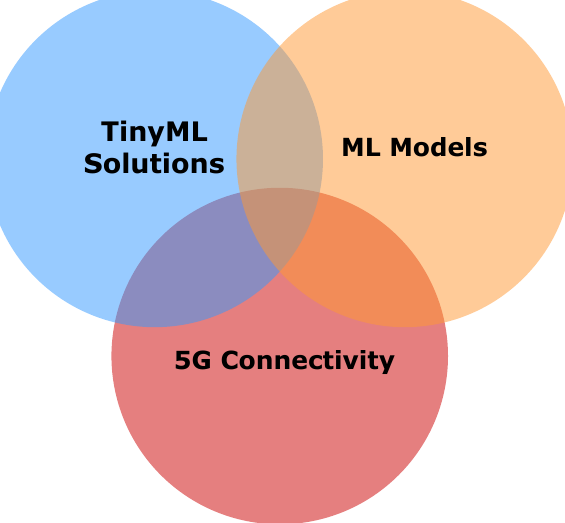
Figure 16. Association of ML, 5G and